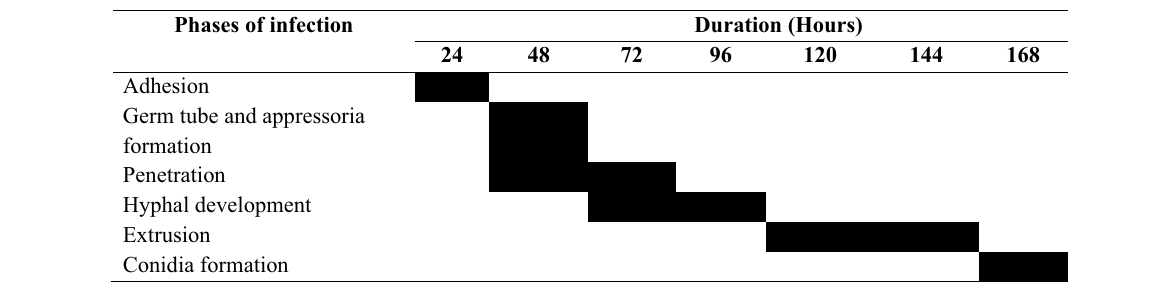
Fig. 9 Stages of infection by Metarhizium anisopliae (TNAU-MA-GDU) at different tested periods after